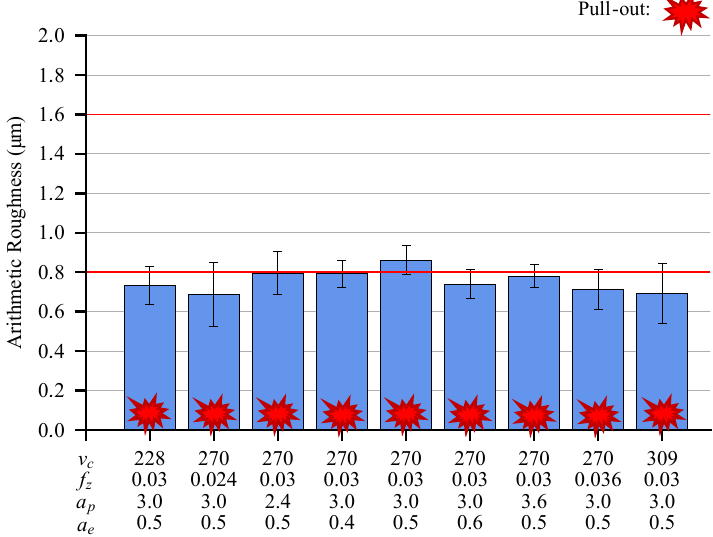
Figure 13. Qualification test of the universal tool, the evolution of Ra (µm) for different v c (m/min), f z (mm/tooth), a p (mm), and a e (mm).